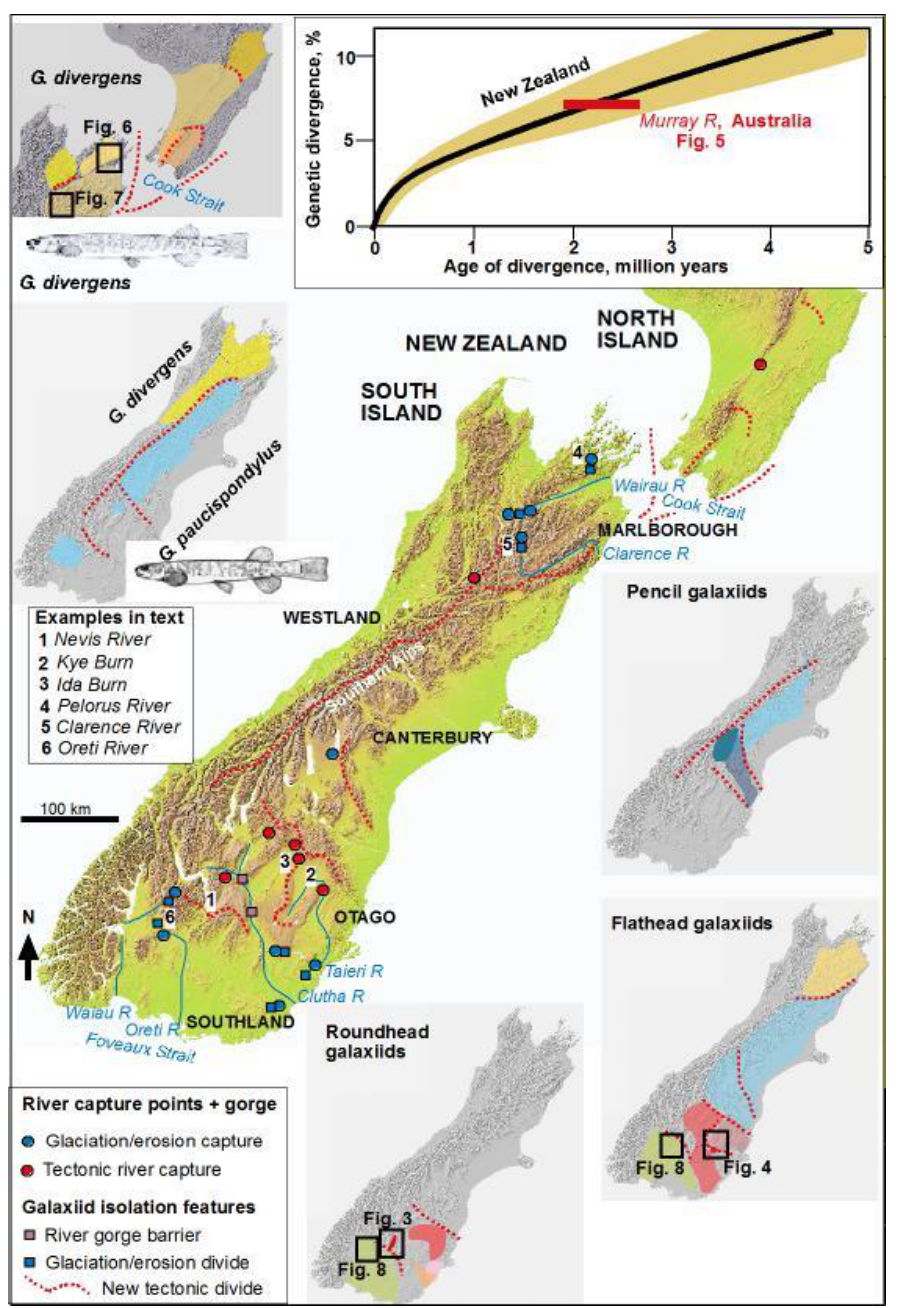
Figure 1. Biogeographic overview of New Zealand’s freshwater-limited Galaxias , showing distributions of distinct species / lineages, and selected geological features linked to their diversification. Identities of ‘roundhead’ and flathead’ lineages are indicated in Figure 2. A calibrated relationship between genetic divergence and geological age of separation (top) has been compiled by combining evidence across many of these river capture events.